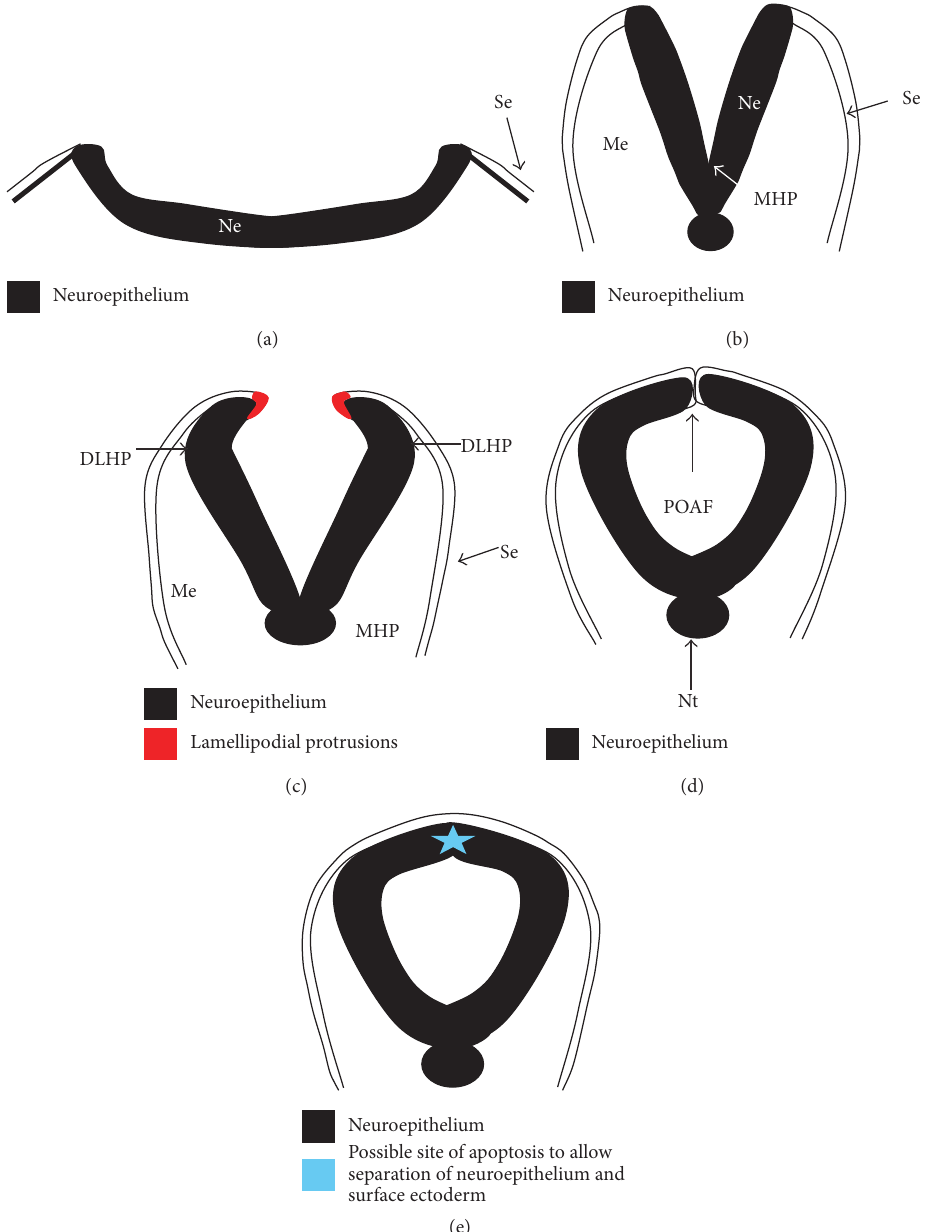
Figure 3: Schematic representation of the formation of the mouse spinal neural tube. Process of closure of the PNP of embryos undergoing Mode 1 (a, b, d) or Mode 2 (a, c, d) neurulation. (a) Neuroepithelium thickens and converges; (b) formation of bilateral neural folds which are elevated (Mode 1); (c) apposing tips of neural folds aided by bending at the dorsolateral hinge points (DLHP) of the bilateral neural folds (Mode 2); (d) adhesion and fusion at the tips of the neural folds; (e) remodeling of the neural tube. Ne, neuroepithelium; Se, surface ectoderm; Me, mesoderm; MHP, median hinge point; DLHP, dorsolateral hinge points; POAF, point of adhesion and fusion; Nt,